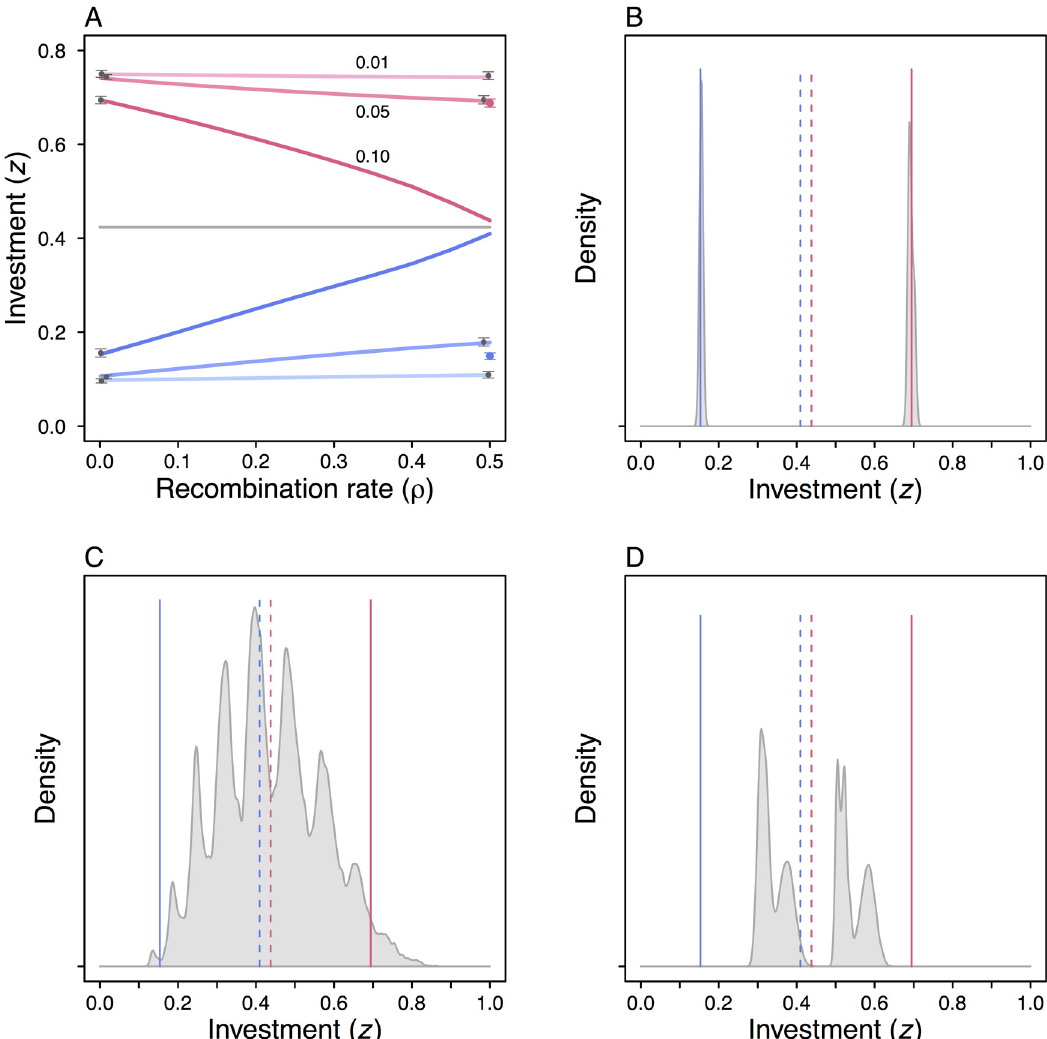
Fig 4. Results from individual-based simulations, illustrating consequences of genetic conflict. (A) Same as the simulations in Fig 2 except that a 0 , in addition to a g , in Eq (5) is determined by a single locus. The blue and red points (with error bars) show the deviating outcome for m = 0.10, ρ = 0.5, which is a consequence of genetic conflict between the cue locus and the locus encoding a g : a g became close to zero, but a 0 became polymorphic, and the polymorphism at the original cue locus collapsed. The outcome is further illustrated in (B), showing a kernel-smoothed distribution of phenotypes in a typical simulation. The blue and red vertical lines show the prediction from Fig 3C, where ρ = 0, and the blue and red dashed lines the prediction from Fig 3D, where ρ = 0.5. The outcome where an unlinked modifier ( a 0 ) takes over the polymorphism depends on the genetic architecture, as illustrated in (B), (C) and (D). In (C) the modifiers a 0 and a g in Eq (5) are each determined by several loci with small additive effects, and the loci contributing to a 0 all became polymorphic. In (D) there is a more complex architecture for a 0 , with additive effects that in turn can be modified with an adjustable threshold limiting the amount of gene expression, and this threshold became polymorphic (see text and S1 Text for further explanation).